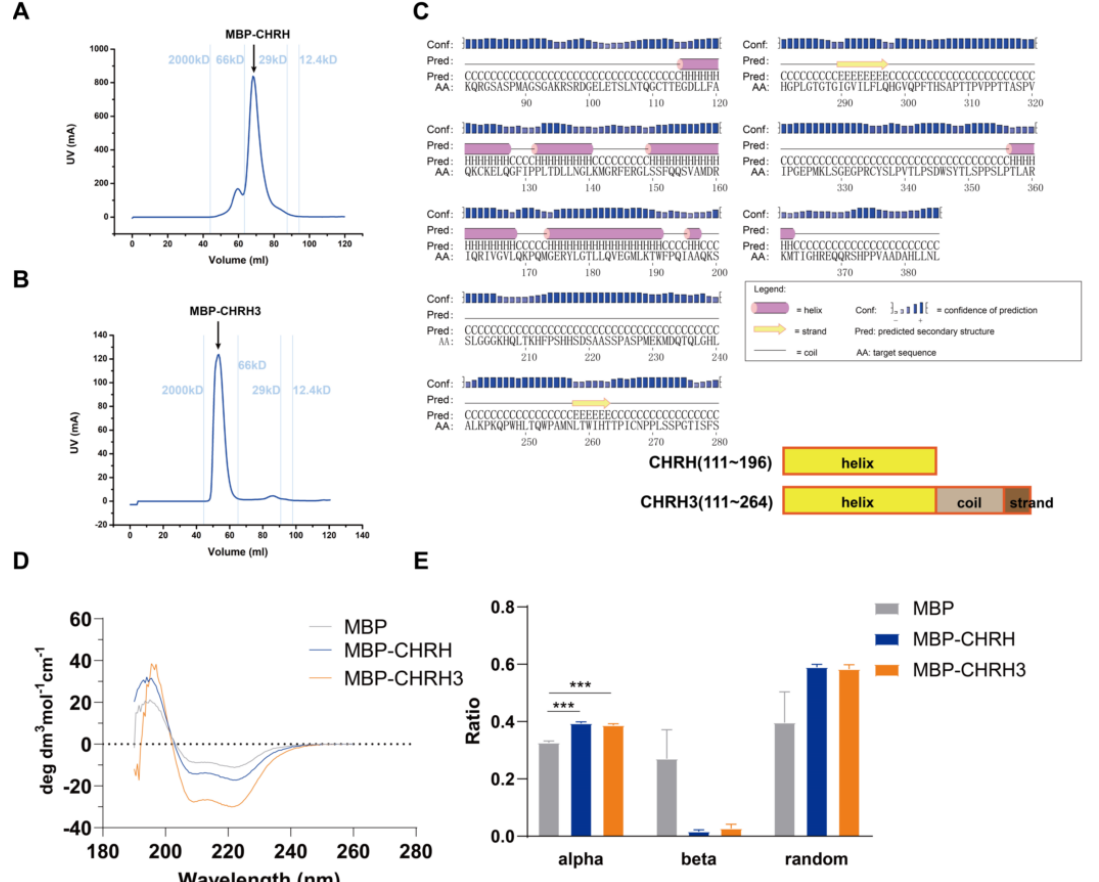
Figure 2. CD spectra ofmaltose binding protein (MBP), MBP-CHRH, and MBP-CHRH3.MBP-CHRH ( A ) and MBP-CHRH3 ( B ) purified by gel filtration chromatography. According to the calibration (molecular weight standards were labeled with light blue lines), MBP-CHRH3 has a larger molecular weight than MBP-CHRH. We collected proteins at the peak area for subsequent experiments. ( C ) According to the result of secondary structure prediction from PSIPRED, CHRH, from 111~196, is mainly composed of α -helix motifs; CHRH3, from 111~264, has extra coils and β -strand motifs in comparison to CHRH. ( D ) Curves of the CD spectra and ( E ) comparisons of the secondary structure contents between MBP, MBP-CHRH, and MBP-CHRH3 proteins. MBP-CHRH and MBP-CHRH3 have similar contents of helixes, while MBP has less helical contents. At least three independent experimental repeats were done for each variant. Graphpad Prism 5 was used to generate graphs / plots and perform statistical analysis (2-tailed unpaired t-test). *** p <